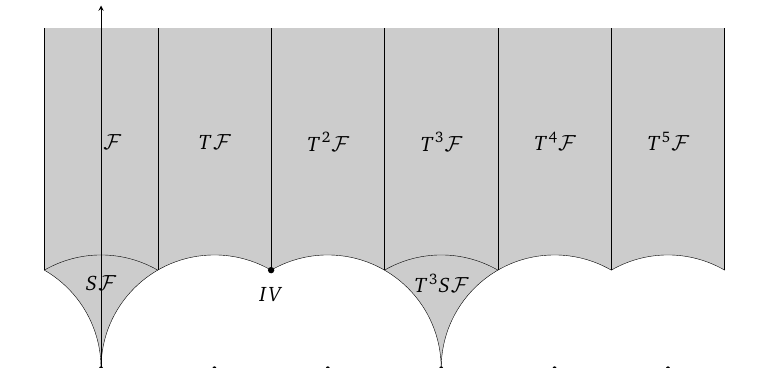
) configuration on the CB of the , IV ,2 I 6 1